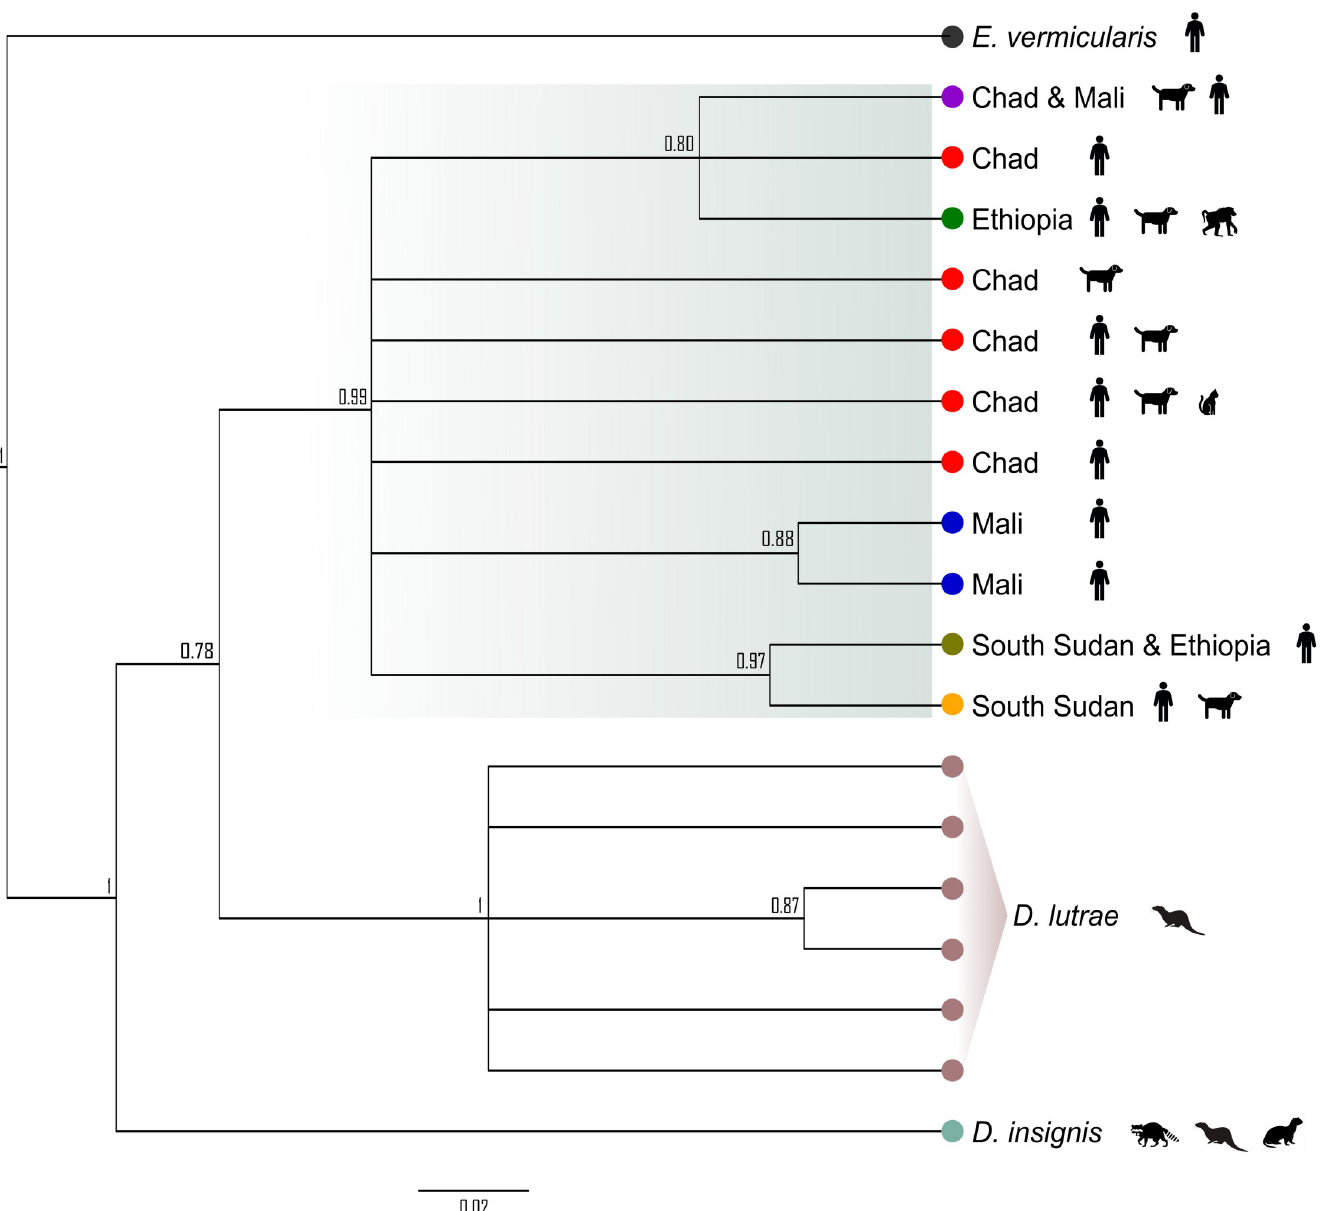
Fig 2. Phylogenetic relationship of African and North American Dracunculus spp. cox1 haplotypes. Genealogical relationship among unique partial cox1 haplotypes found in a subset of African D . medinensis and North American D . insignis and D . lutrae (North American species sequences from [10]). Country of origin (for African samples) and parasite species are defined beside each branch. Definitive host species from which all or some of the parasite haplotypes were recovered are indicated by icons to the right of the tree. Trees were inferred in MrBayes v3.2.6 [36] with two independent MCMC analyses of 1 million generations each. Posterior probabilities indicated at branch